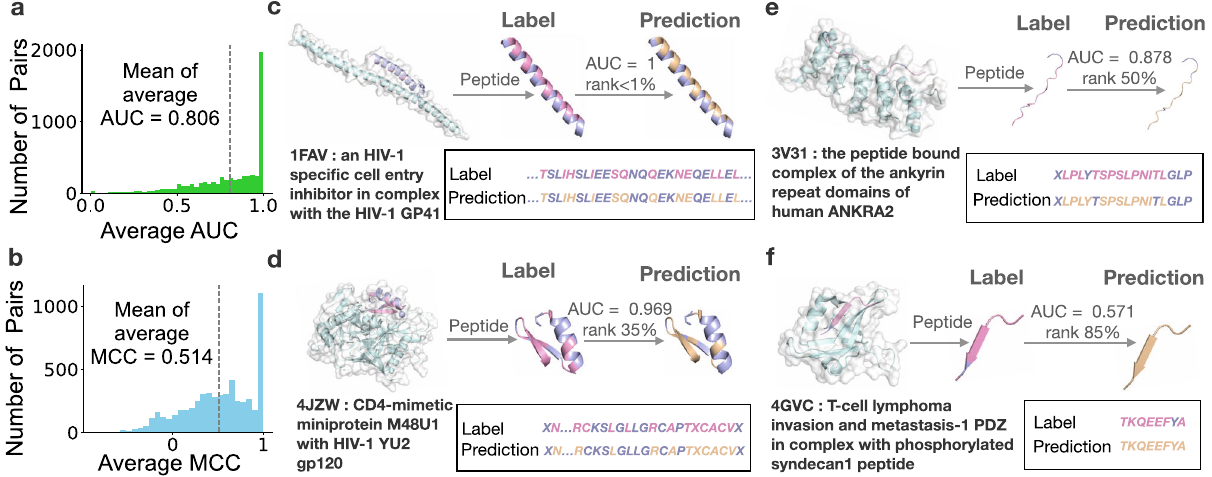
Fig. 3 Performance evaluation of CAMP on peptide-binding residue identi fi cation on the benchmark data set through fi vefold cross-validation. a , b show the distributions of AUC and MCC for peptide-binding residue prediction, respectively. The mean values of average AUC and MCC are plotted in dotted lines. c – f show four examples of peptide-binding residue identi fi cations by CAMP that ranked ~1%, 35%, 50%, and 85% in terms of average AUC, respectively. The PDB complexes were retrieved from the RCSB PDB 21,22,59 and the images were generated by PyMOL 60 . The protein chains in the complexes are colored in light blue while the peptide chains are colored in light purple and pink. For each peptide, the true binding residues are colored in pink while the predicted binding residues generated by CAMP are colored in